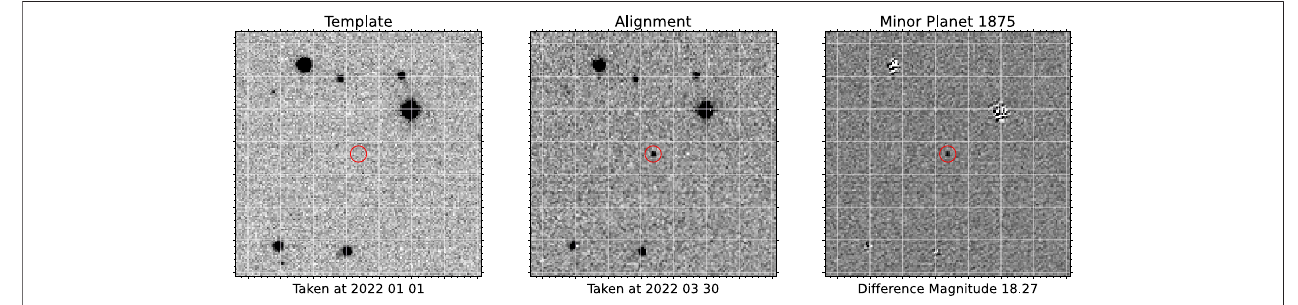
FIGURE 8 | Example of the QIP: the detection of minor planet # 1875 at magnitude 18.27. The left panel shows the template image taken on 1 January 2022, and the middle panel shows the remapped image taken on 30 March 2022. The right panel shows the difference images produced by the QIP pipeline.